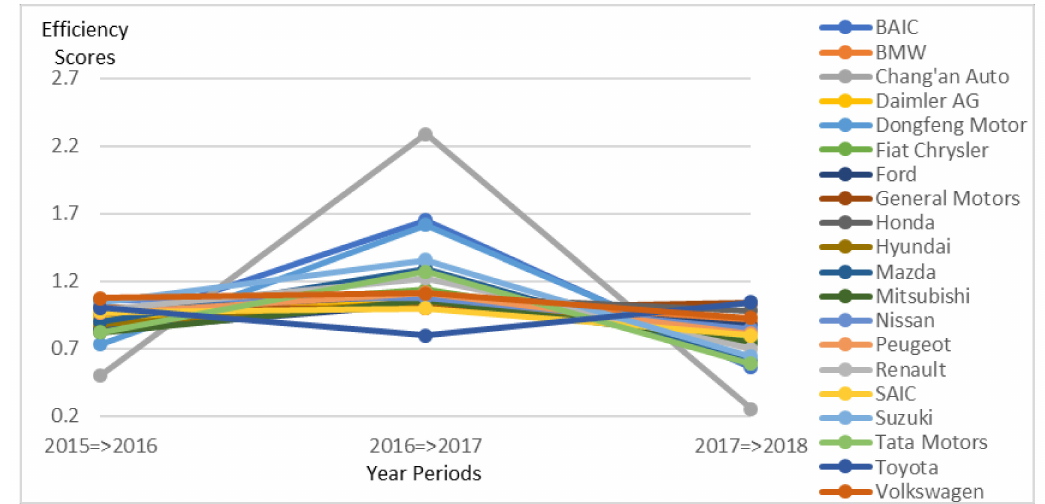
Figure 10. Total-factor-productivity